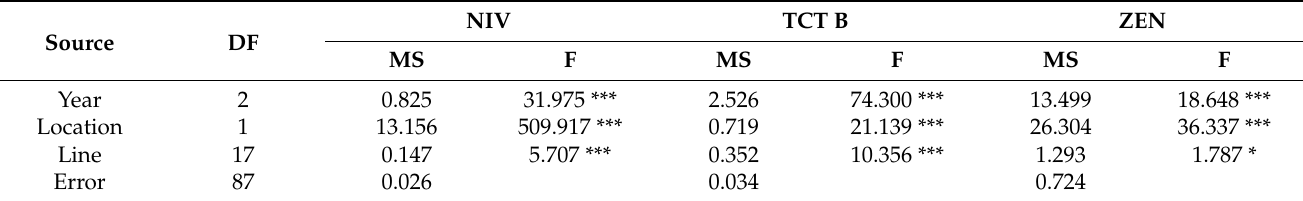
Table 8. Analysis of variance of concentration of nivalenol, trichothecenes B (sum of DON, 3AcDON, 15AcDON, and NIV) and zearalenone in grain.